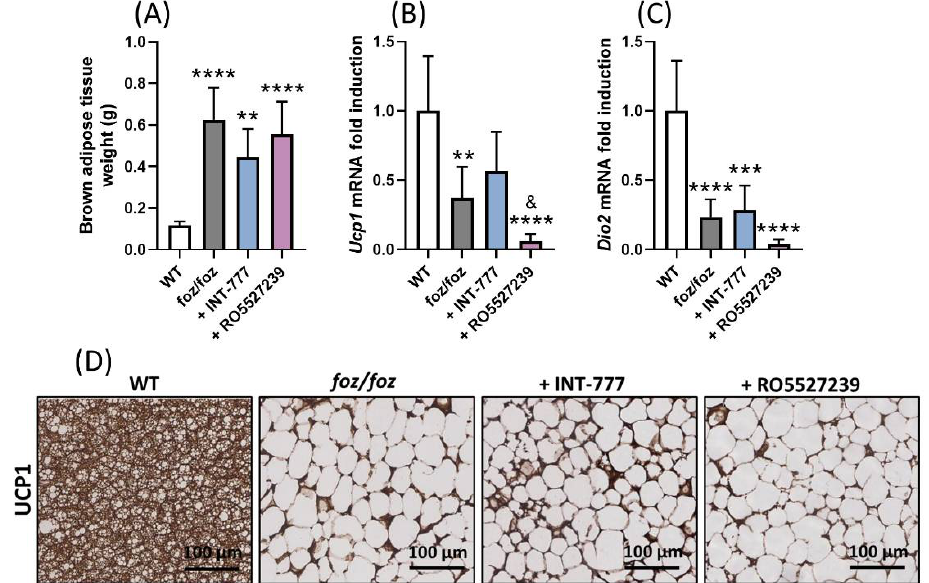
Figure 6. RO5527239-induced activation of TGR5 in peripheral tissues does not rescue brown adipose thermogenesis. ( A ) Brown adipose tissue weight. ( B , C ) Gene expression of Ucp1 and Dio2 , and ( D ) representative UCP1 staining in the brown adipose tissue of WT, foz/foz , foz/foz + INT-777 and foz/foz + RO5527239 mice (n = 7/group). Mean ± SD. One-way ANOVA followed by post hoc Bonferroni correction. Statistical significance is represented by ** p < 0.01; *** p < 0.001 and **** p < 0.0001 when compared to WT; and & p < 0.05 when compared to foz/foz + INT-777. All p -values < 0.05 are represented on the graphs, while p -values > 0.05 are not.